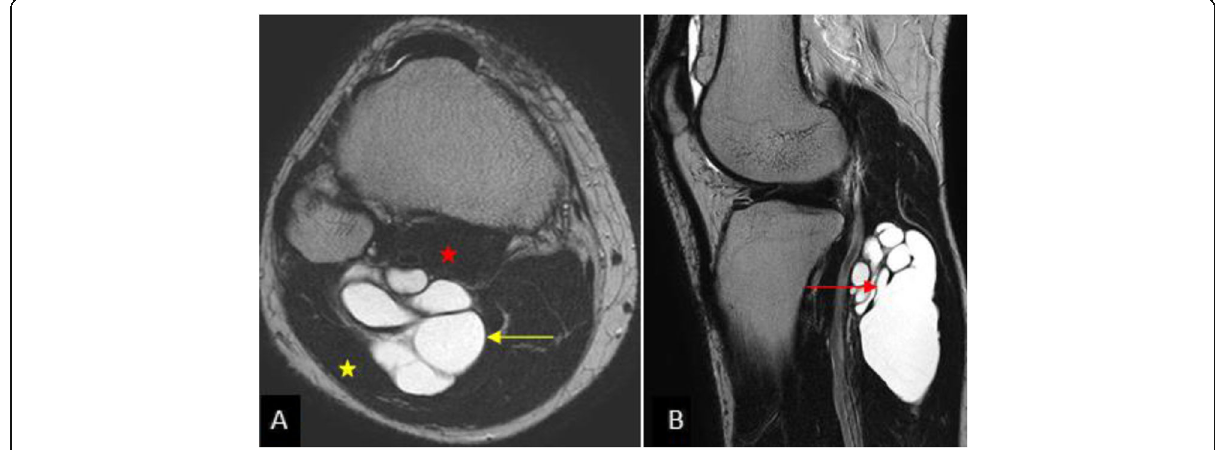
Fig. 1 Thirty-year-old male with lymphangioma in the proximal leg along the posterior aspect. Findings: axial ( a ) and sagittal ( b ) T2WI images at the level of the proximal leg showing a multiloculated high-signal intensity lesion in the intermuscular plane between the soleus (yellow arrow) and lateral head of the gastrocnemius muscles (yellow asterisk). Multiple thin internal septations seen within predominantly in the superior aspect (red arrow). The lesion appears to be away from the joint with no intra-articular continuation. Technique: Philips Insta 1.5-T MRI — T2WI axial and sagittal: TR 4843 ms, TE 100 ms, matrix 324 × 260 and slice thickness 3